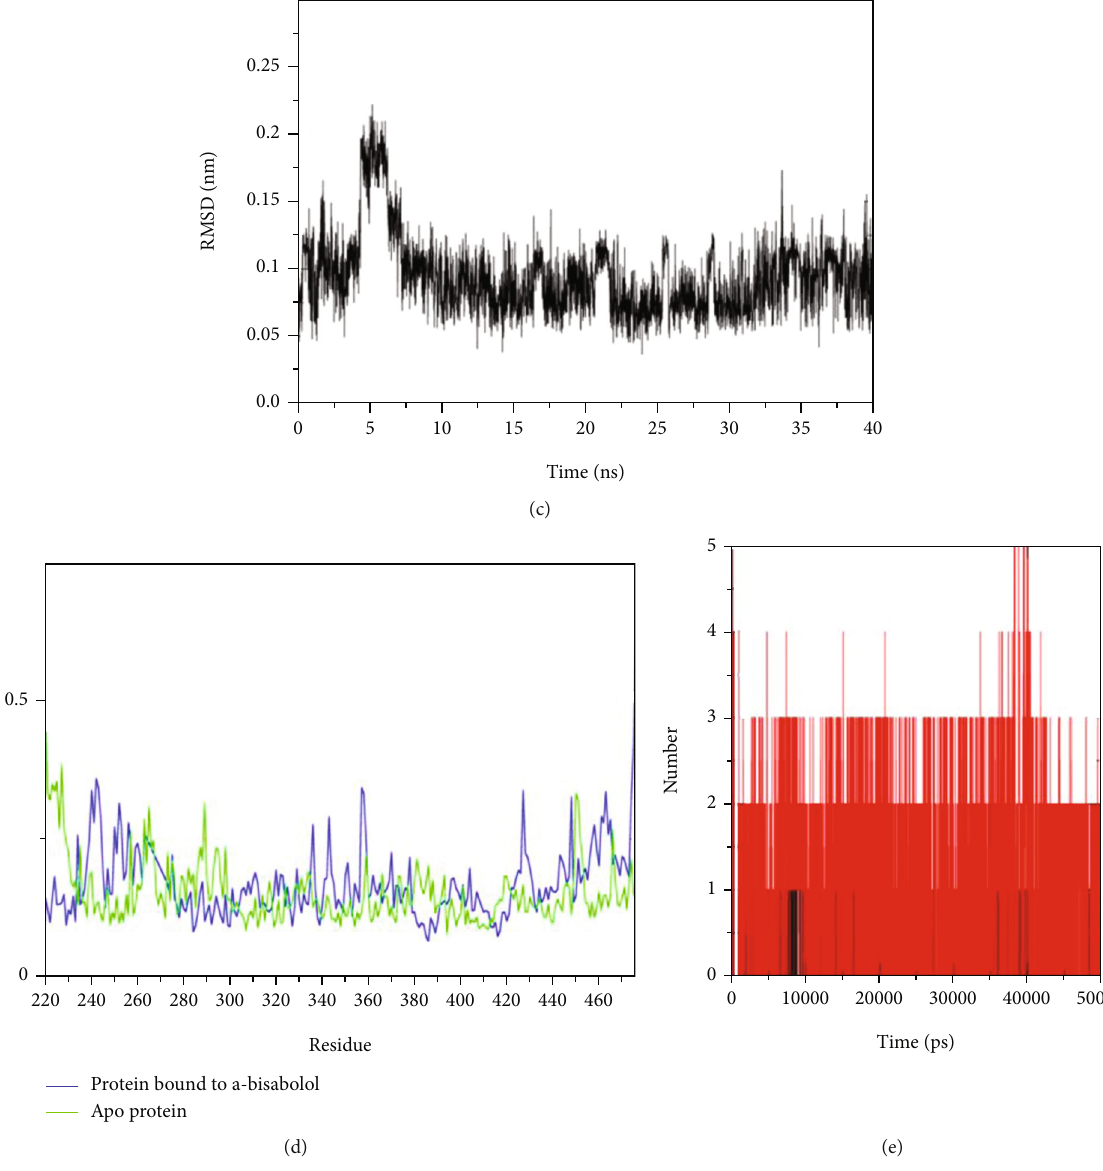
Figure 1: The docked pose of α -bisabolol and lobeglitazone and the interactions at the binding site of PPAR- γ and molecular dynamics studies. (a) Docked and cocrystallized poses of lobeglitazone are shown in blue and red stick representations, respectively. Insert picture indicates the interactions of lobeglitazone and the interactions of α -bisabolol at the binding site of PPAR- γ . (b) RMSD in protein backbone atoms, (c) RMSD in α -bisabolol atoms, (d) RMSF in PPAR- γ residues, and (e) hydrogen bond analysis for α -bisabolol (black lines represent hydrogen bonds, and red lines represent hydrogen bond pairs within 0.35 nm region).